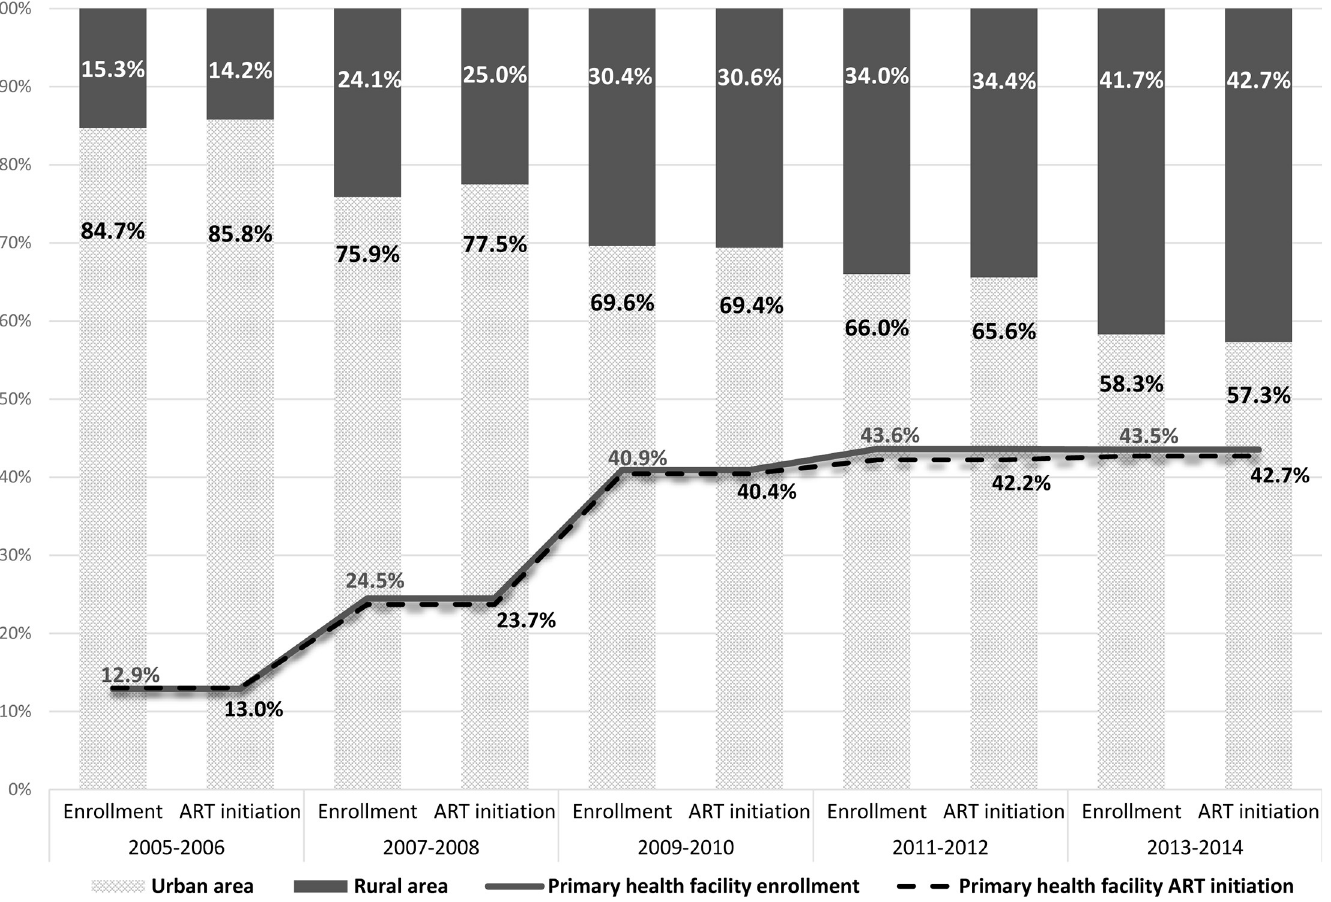
Fig 1. Proportions of PLHIV enrolling in HIV care and initiating ART by location (urban vs. rural) and at primary health facilities by year in Ethiopia, Kenya, Mozambique and Tanzania, 2005–2014 (N = 884,828).